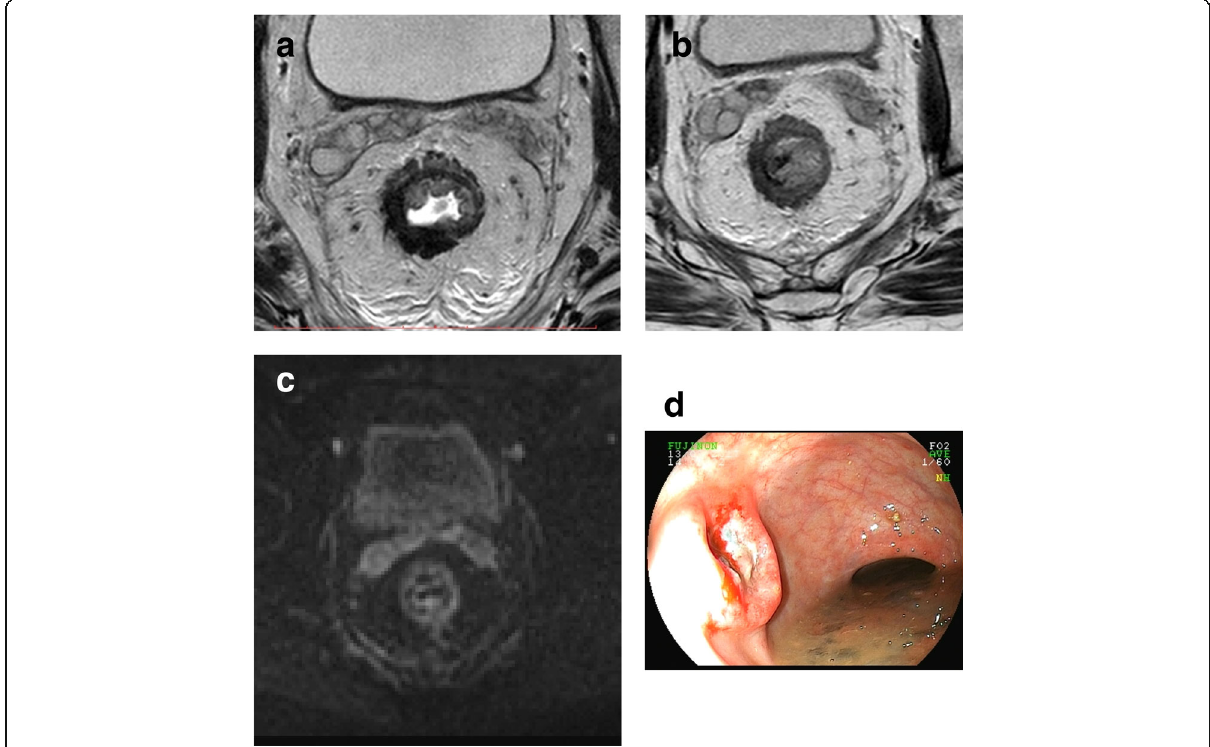
Fig. 14 Luminal regrowth detected exclusively by endoscopy. Images show a clear endoscopic view of a regrowth following initial complete clinical response with no relevant radiological findings. a High-resolution T2WI restaging axial image 16 weeks after neoadjuvant therapy shows a low signal intensity scar from 5 to 9 o ’ clock. Watch-and-wait was offered. b Follow-up exam after 12 months showed less extensive, from 7 to 10 o ’ clock persistent low signal intensity scar with no signs of regrowth. c DWI ( B = 700) was unremarkable. d Endoscopy showed obvious regrowth at 12 months and the patient was sent to salvage resection. Total mesorectal excision was performed; ypT2N0 with free margins was